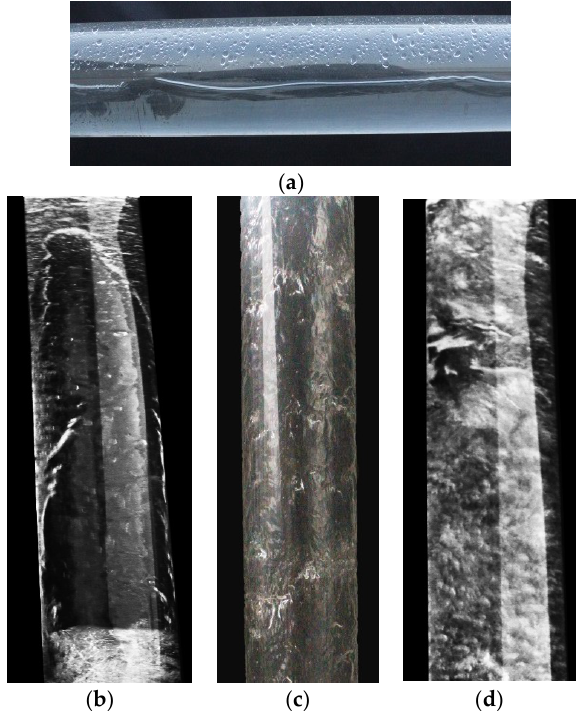
Figure 4. The flow pattern observed in the experiment: ( a ) laminar flow (inclined angle is 0°); ( b ) slug flow (inclined angle is 30°); ( c ) annular flow (inclined angle is 90°); ( d ) transition flow (inclined angle is 90°).